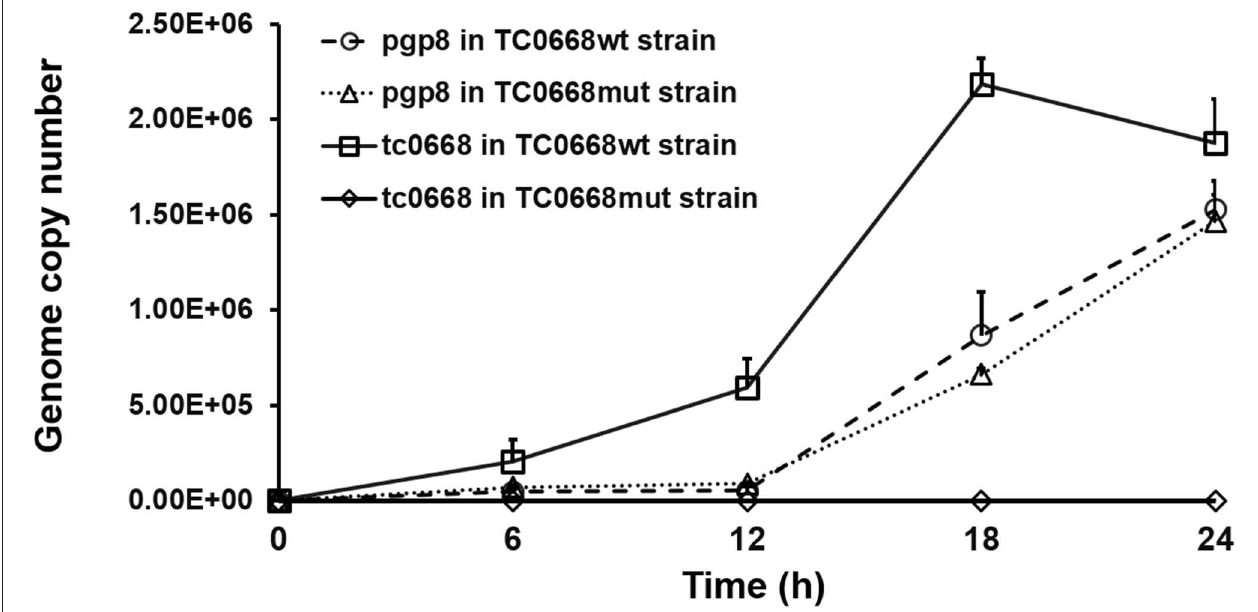
FIGURE 2 | qRT-PCR analysis of tc0668 gene copy number in C. muridarum TC0668 wt - and TC0668 mut -infected HeLa cells. With 1 × 10 6 IFU/well inoculum (MOI = 1), the copy number of the C. muridarum gene tc0668 was determined using qRT-PCR, and the C. muridarum plasmid gene pgp8 was used as the control. 16S rRNA was used to normalize tc0668 and pgp8 signals. Three biological replicates of each time point were performed, and points represent mean and standard errors. Copy number differences of tc0668 between TC0668 wt - and TC0668 mut -infected cells were statistically significant (one-way ANOVA, P < 0.05).